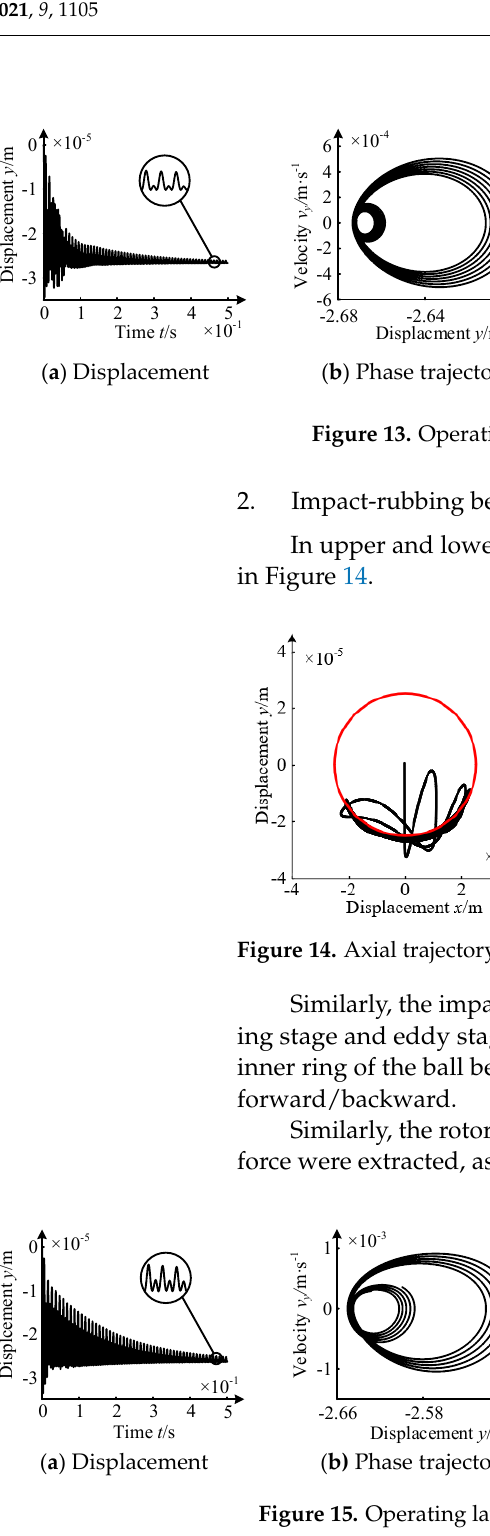
the inner ring of the ball bearing, it bounces and collides firstly and then vortexes repeat-